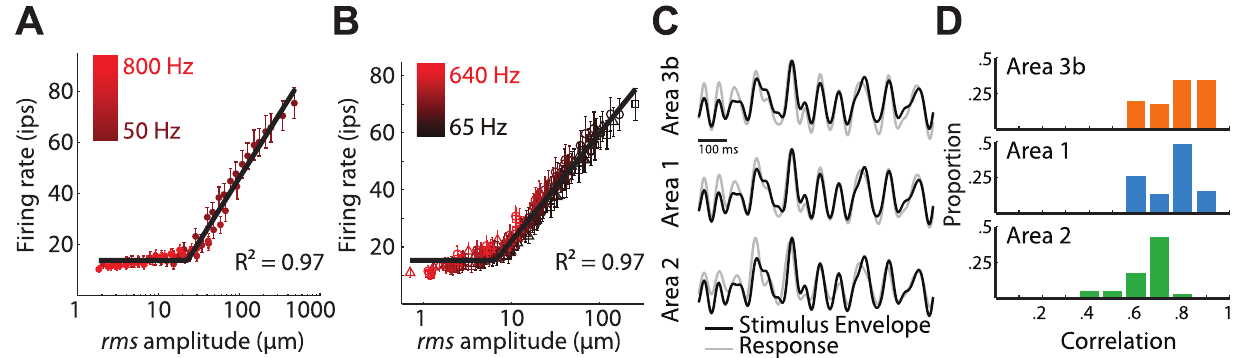
Figure 1. Stimulus amplitude versus firing rates. (A) Mean rate-intensity function for neurons in area 3b, computed from responses to sinusoids; marker colors change from dark to bright red with increasing stimulation frequency; error bars denote standard error of the mean. The shallow and frequency-independent increase in firing rate at low amplitudes is due to progressive neuronal recruitment and is not observed in the responses of individual neurons (see Figure S1A). (B) Rate-intensity function for neurons in area 3b, computed from responses to band-pass noise stimuli; colors change from dark to bright red as the center frequency of the noise increases; markers denote different noise conditions (triangle, noise A ; circle, noise V ; square, noise P , see Materials and Methods). For both individual neurons and neural populations, responses are independent of the frequency composition of the stimulus. (C) Hilbert transform of a sample noise stimulus (black) and smoothed time-varying population firing rates (gray) in areas 3b (top), 1 (middle), and 2 (bottom). The neural response is time-shifted to account for neural delays. (D) Mean correlation between the time-varying population response and the logarithm of the stimulus envelope in the three